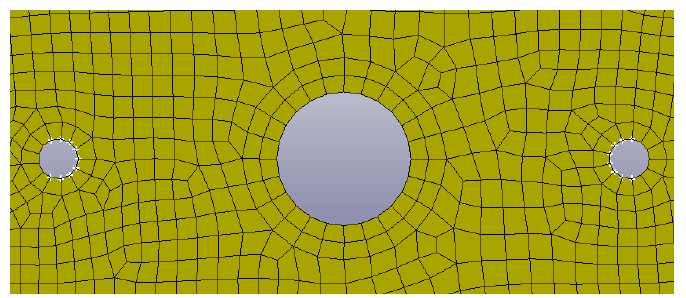
Figure 16. Particular of the model with the constrains on the internal edge of the support pin holes.